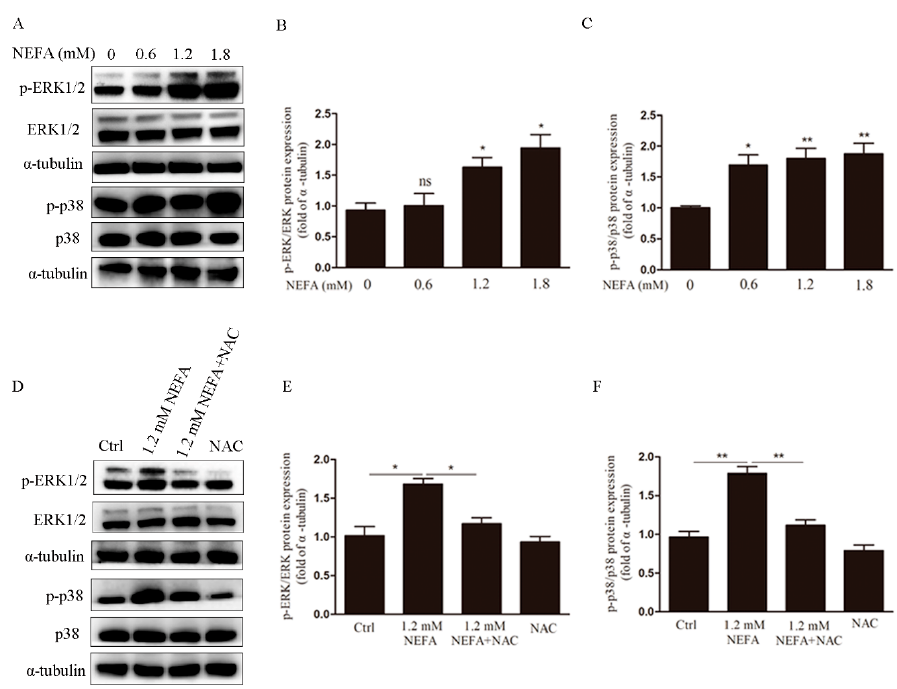
Figure 5. ERK1 / 2 and p38 pathways are involved in NEFA induced ROS mediated apoptosis of GCs. ( A – C ) After treatment with different concentrations of NEFA, p-ERK1 / 2, ERK1 / 2, p-p38, and p38 levels were assayed by western blotting. ( D – F ) After pre-treatment with NAC, protein expression of p-ERK1 / 2, ERK1 / 2, p-p38, and p38 were evaluated by western blotting. These results indicated that the ROS induced by NEFA activated the ERK1 / 2 and p38 pathways. Data are presented as mean ± SEM, * p < 0.05, and ** p < 0.01.